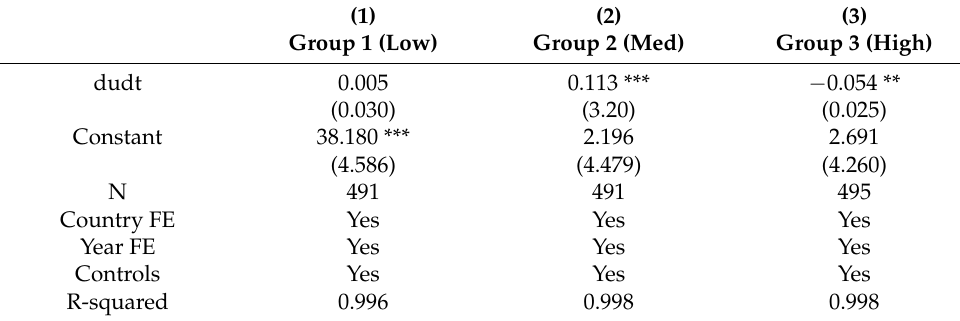
Table 9. Regression results for the three